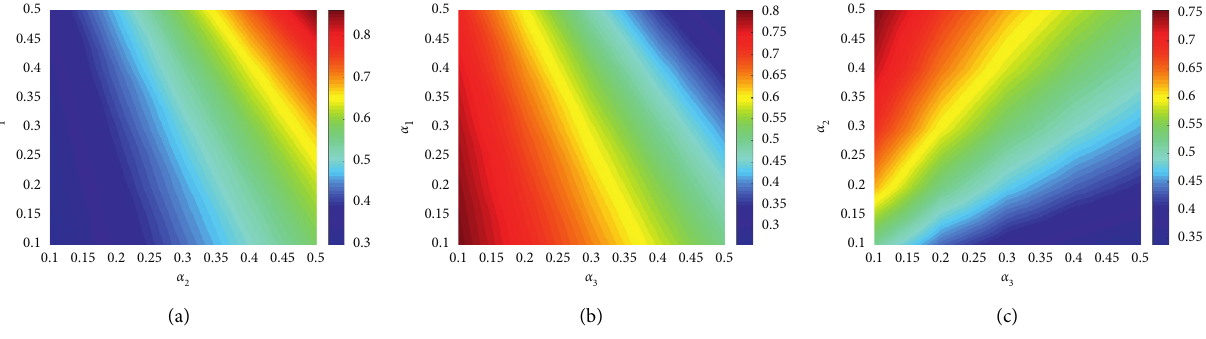
Figure 9: Parameters on the expected probability of buying for node 30: (a) α